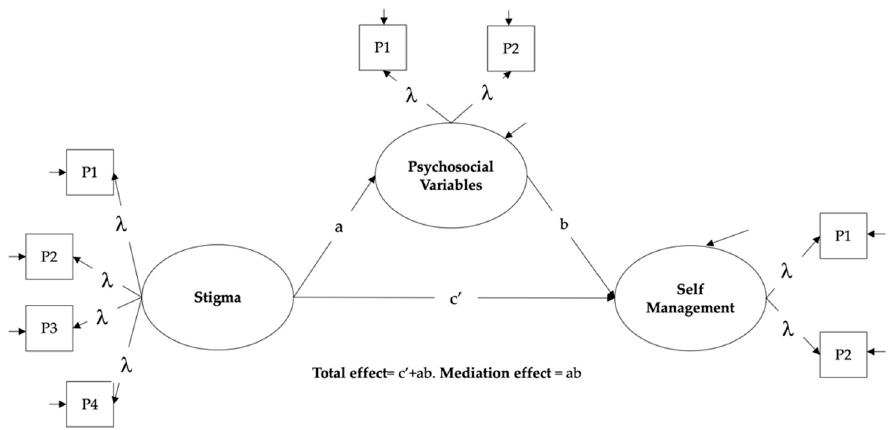
Figure 1. Structural Equation Model for Mediation Analysis. The paths a, b, and c’ represent regression coefficients. Circles: latent variables. Squares: indicators, parcels (P) in this case. λ : factor